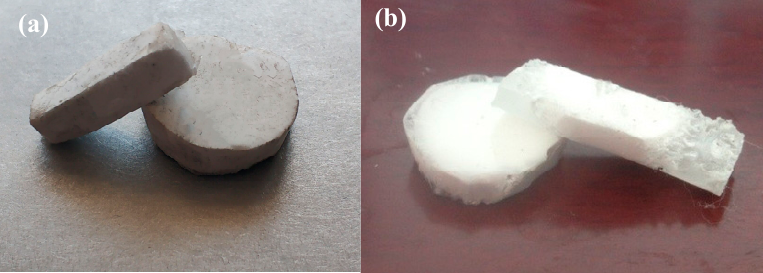
Figure 2. ( a ) Macroscopic morphology of porous alumina; ( b ) Macroscopic morphology of layered Al 2 O 3 /PMMA composite.